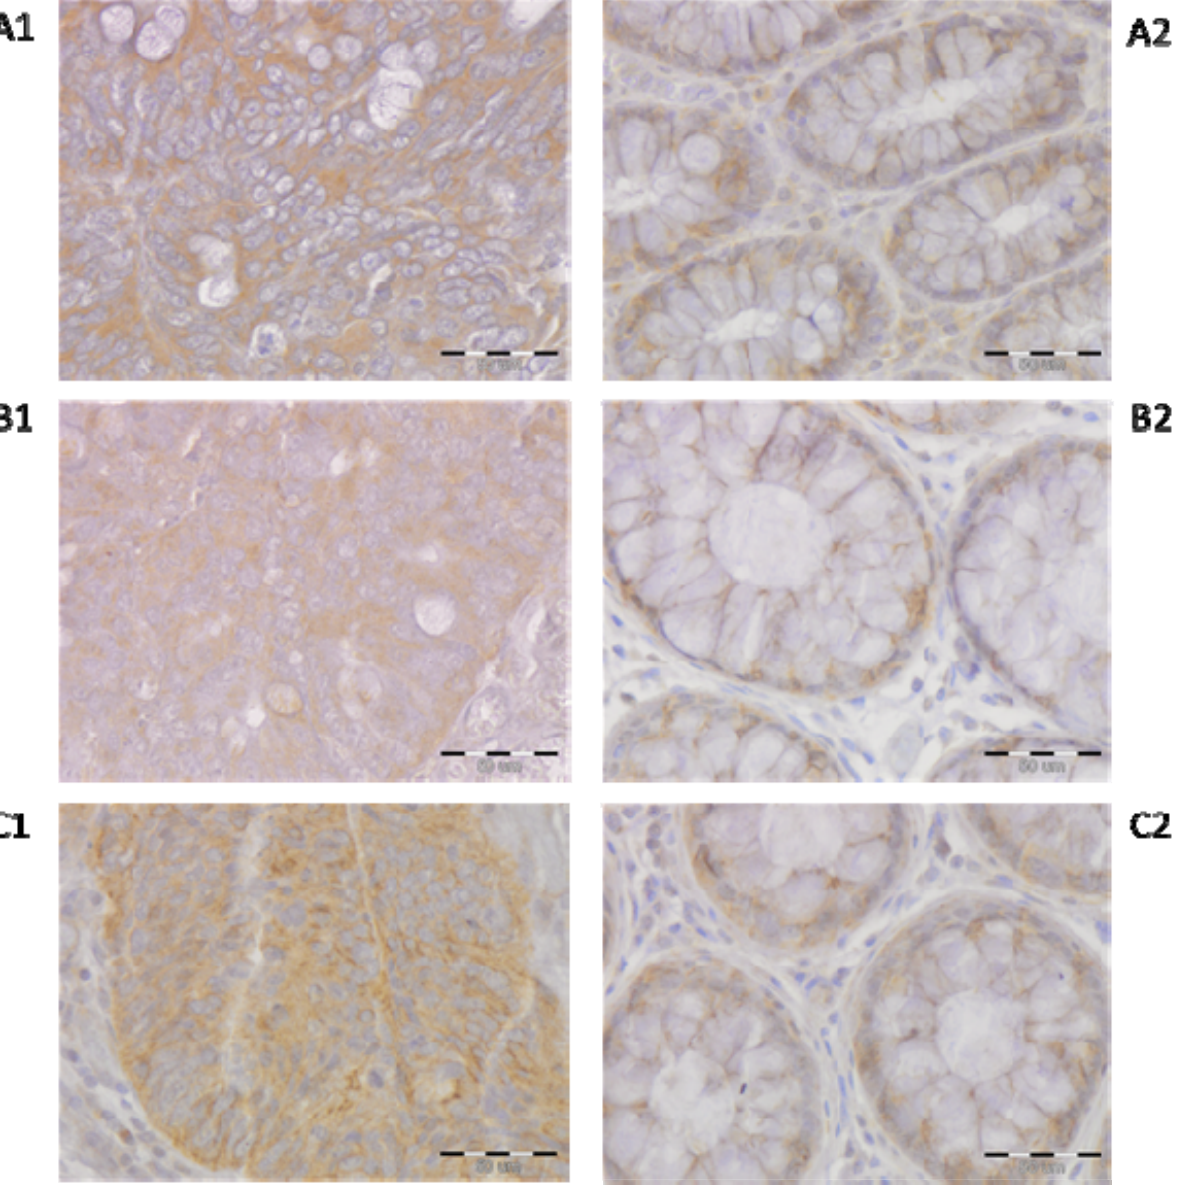
Figure 1. Immunohistochemical expression of galanin receptors (GalR1, GalR2 and GalR3) in col- orectal cancer cells ( A1 , B1 and C1 , respectively) was compared with their immunoreactivity in the epithelial and stromal cells of the unchanged mucosa of the same representative colorectal cancer (CRC) patients ( A2 , B2 , and C2 , respectively), as in Figure 1. The data shown here are representative for 10 slides of CRC tissue and unchanged mucosa tissue. Total magnification: 400 × , the size of the scale bar in the Figure is 50 µm for each microphotograph.